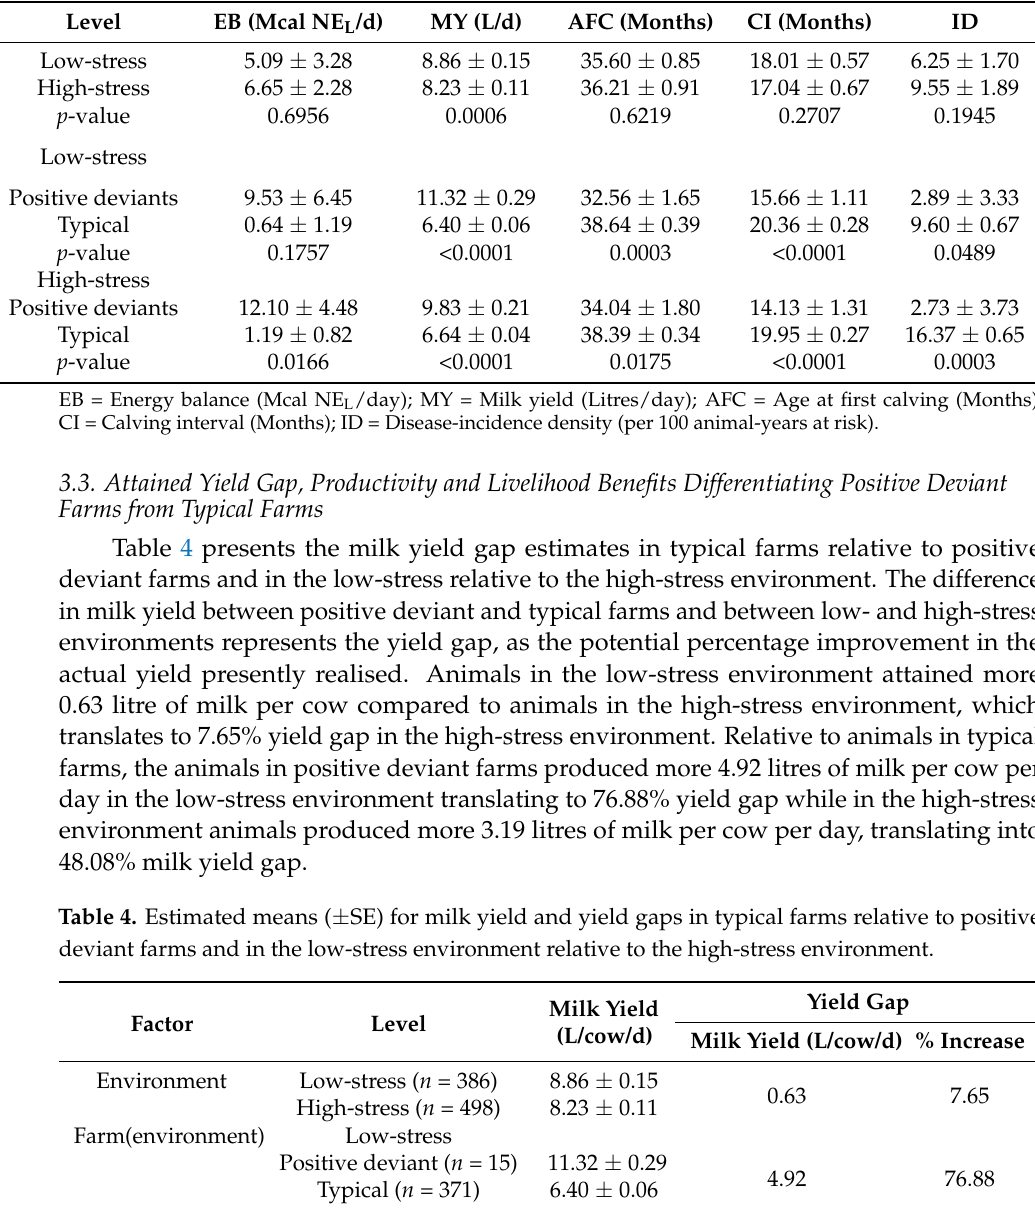
Table 3. Estimated means (LSMEANS ± SE) for performance-indicator variables of cattle managed on positive deviants and typical smallholder dairy farms nested within production environments.